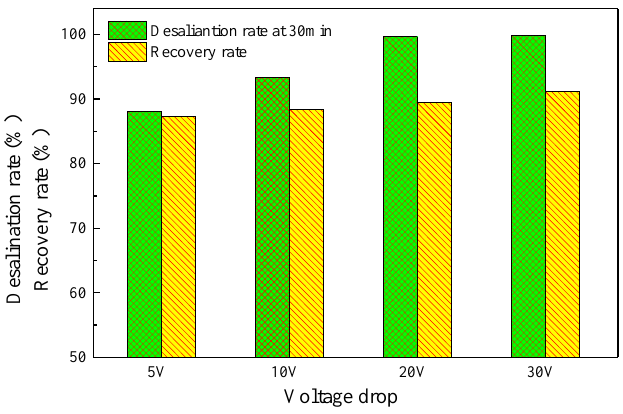
Figure 3. Desalination and recovery rates of MSM solution under di ff erent voltage.